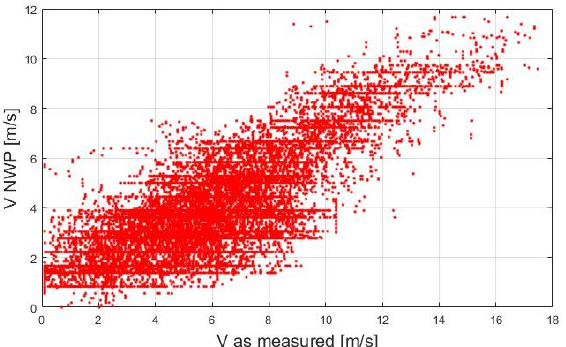
Figure 29. Correlation of the wind velocity values as measured and as predicted by NWP for wind power plant